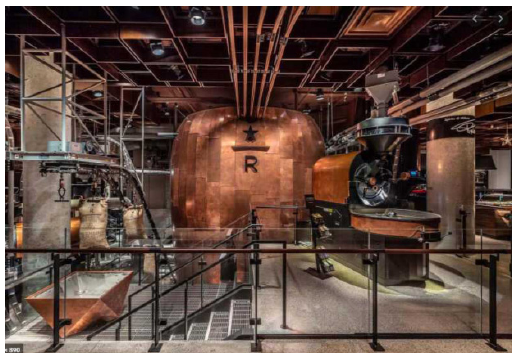
Figure 37. Roasting machine at Starbucks Reserve Roastery in New York [87].